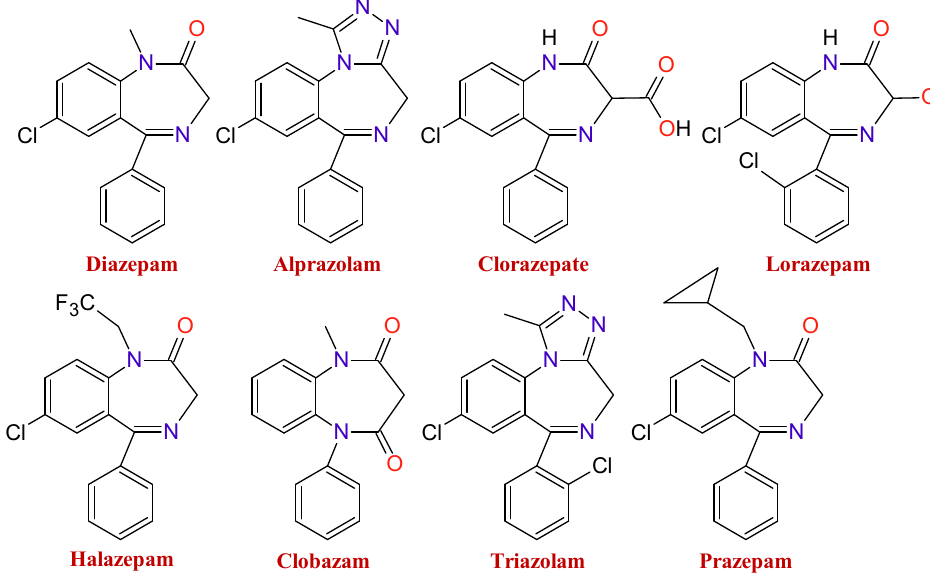
Figure 1. Benzodiazepines basic structure.